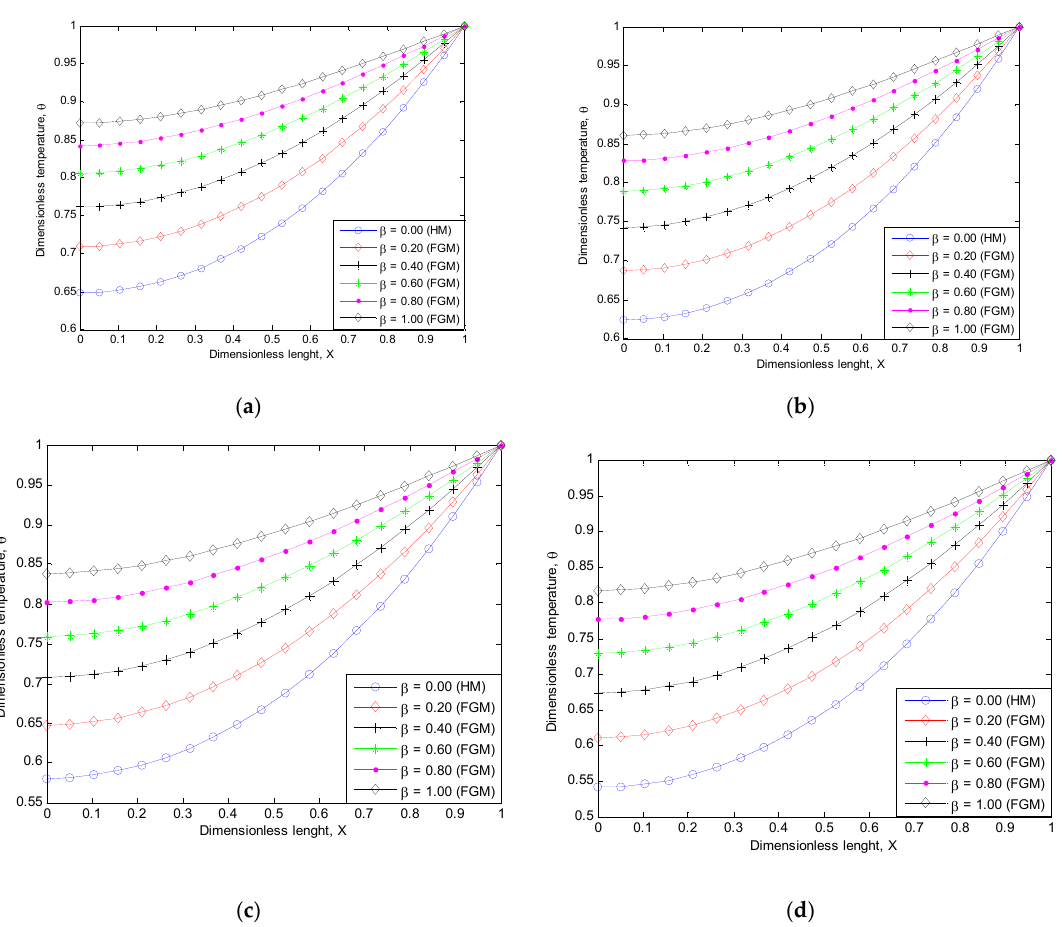
Figure 4. Fin dimensionless temperature profile for varying thermo-geometric parameter under power-law function when: ( a ) Nr = 0.0, Ra = 0.01, Nc = 1.0; ( b ) Nr = 0.1, Ra = 0.01, Nc = 0.5; ( c ) Nr = 0.1, Ra = 0.01, Nc = 0.6; and ( d ) Nr = 0.2, Ra = 0.01, Nc = 0.5.